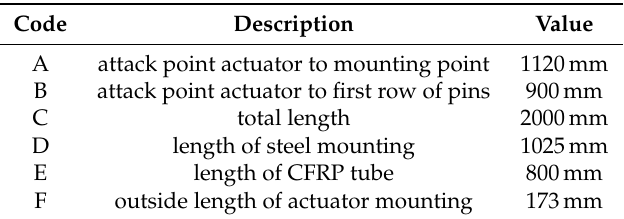
Figure 3. ( a ) Technical drawing of the rudder stock; ( b ) close-up of the interface between steel and CFRP, including pin locations arranged in six pin rows. Table 1. Detailed description of the dimensions shown in Figure